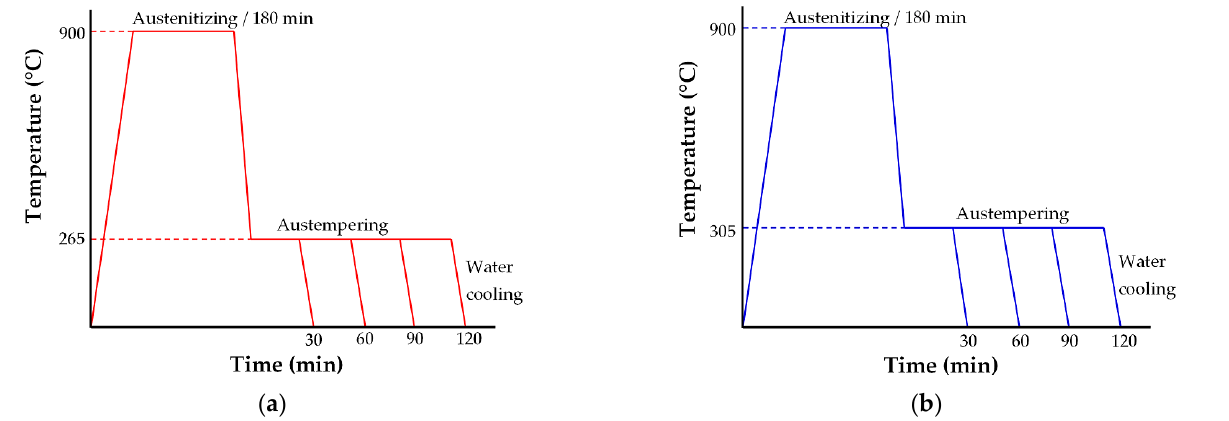
Figure 3. Austempering heat treatment cycles for temperatures of ( a ) 265 and ( b ) 305 °C.